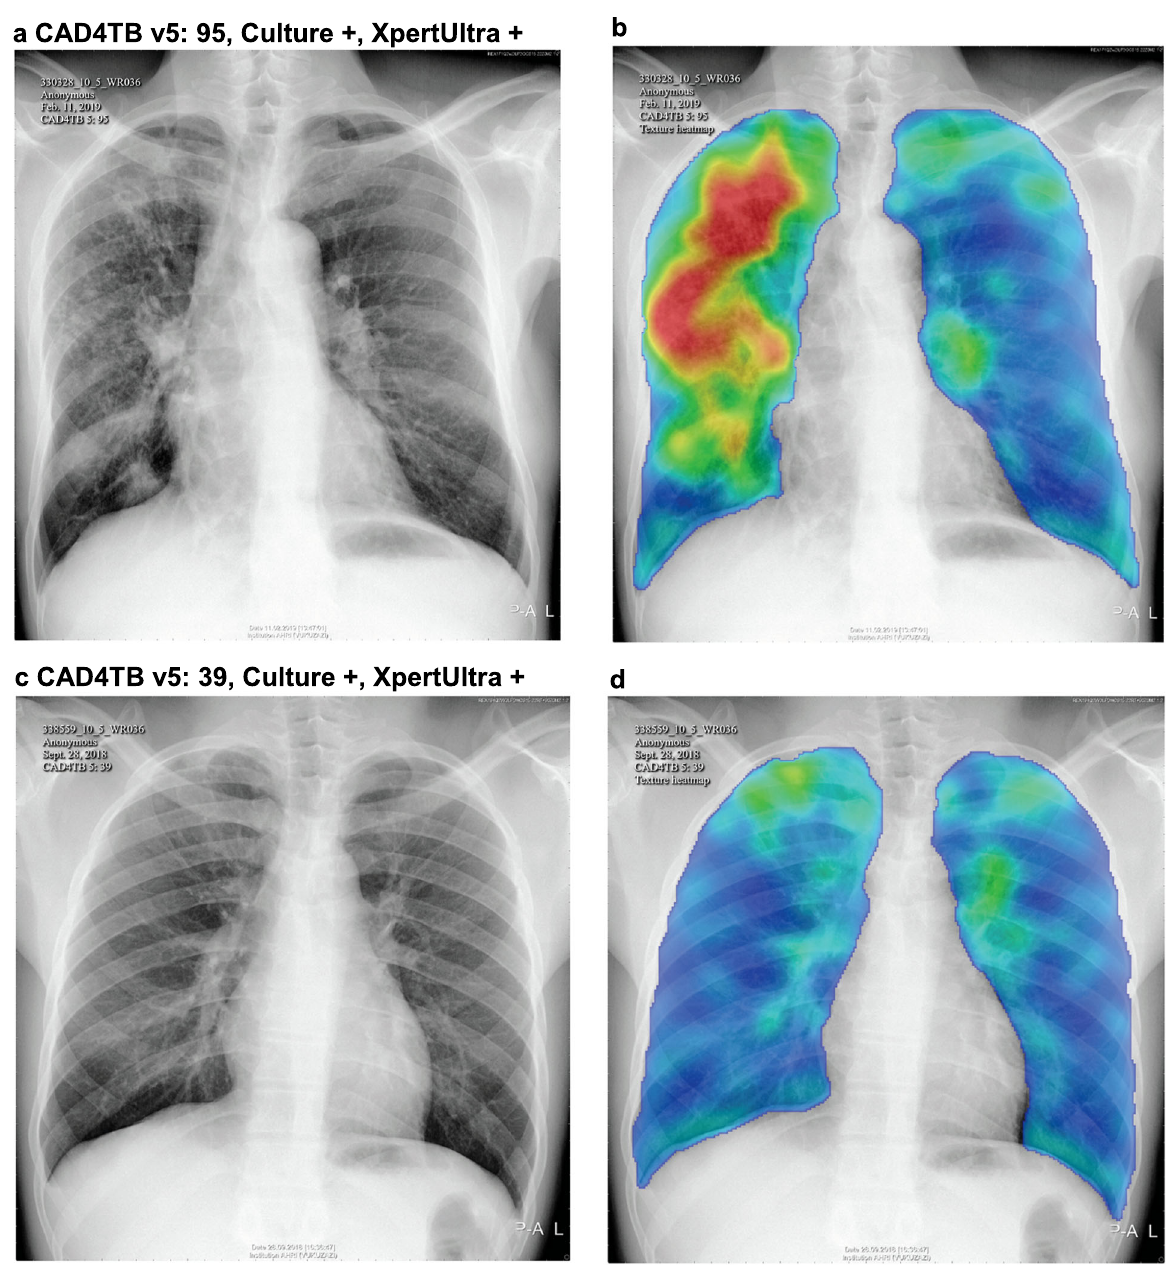
Fig. 2 Radiographic spectrum of two participants with microbiologically con fi rmed active TB. Digital CXR images and the corresponding CAD4TBv5 heatmaps (blue colors mark normal lung fi elds and red marks TB-related abnormalities contributing to CAD4TB score). Participant 1 ( a , b ) was 62 years old, HIV-positive on ART, and had a CAD4TB v5 score of 95 which the radiologist assessed as abnormal and diagnostic of TB. Participant 2 ( c , d ) was 31 years old, HIV-negative, and had a CAD4TB v5 score of 39, which the radiologist assessed as normal. Both participants had positive liquid culture and XpertUltra (greater than trace) results, no TB symptoms, and no history of previous TB